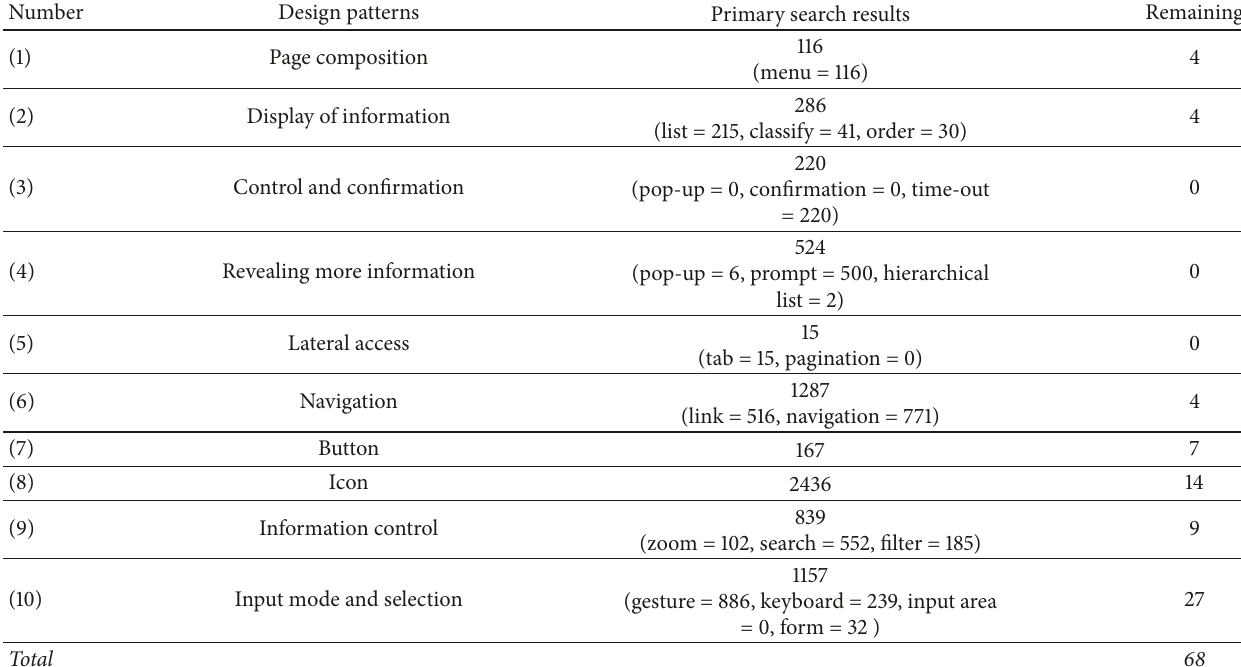
Table 3: Primary search results and remaining papers in each